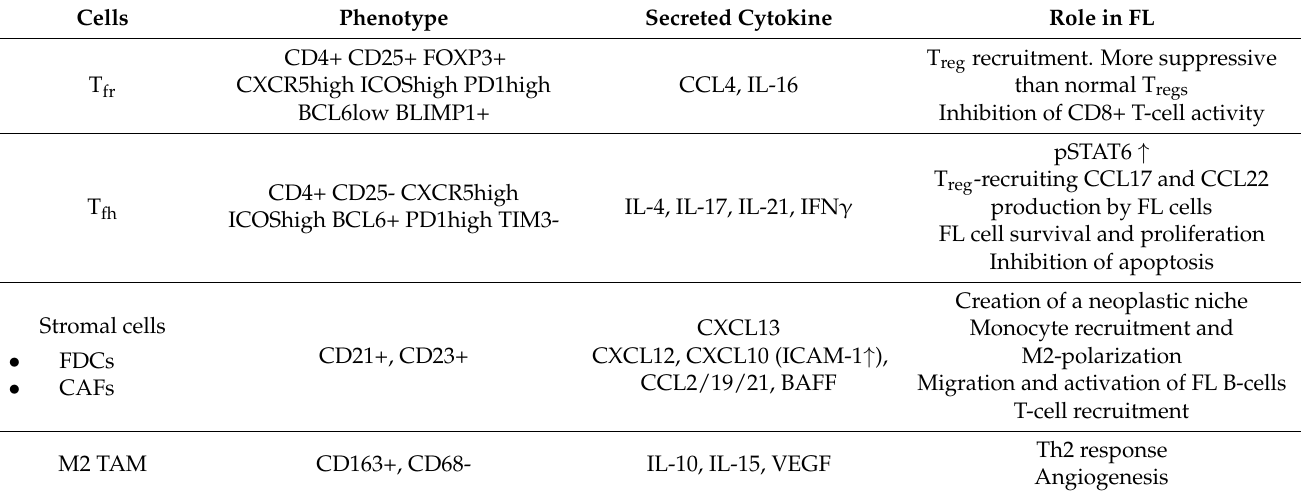
Table 1. Main cells involved in the tumor microenvironment of follicular